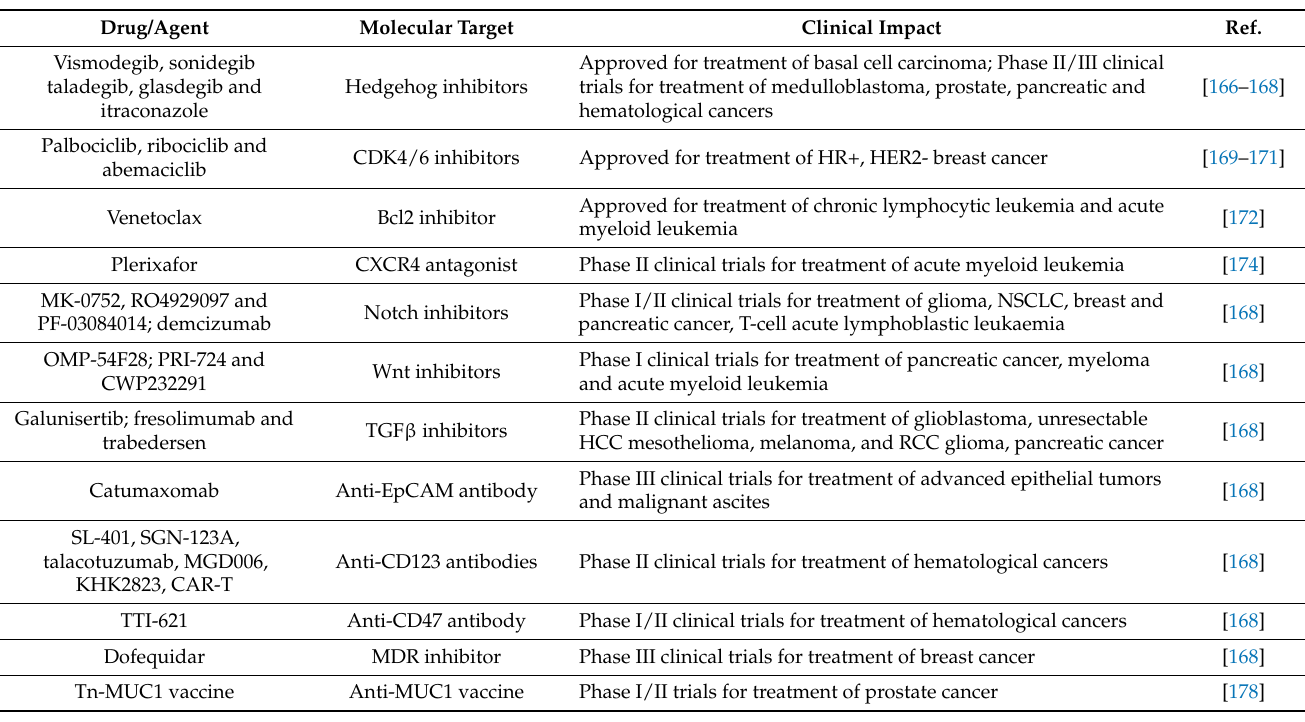
MK-0752, RO4929097 and PF-03084014; demcizumab